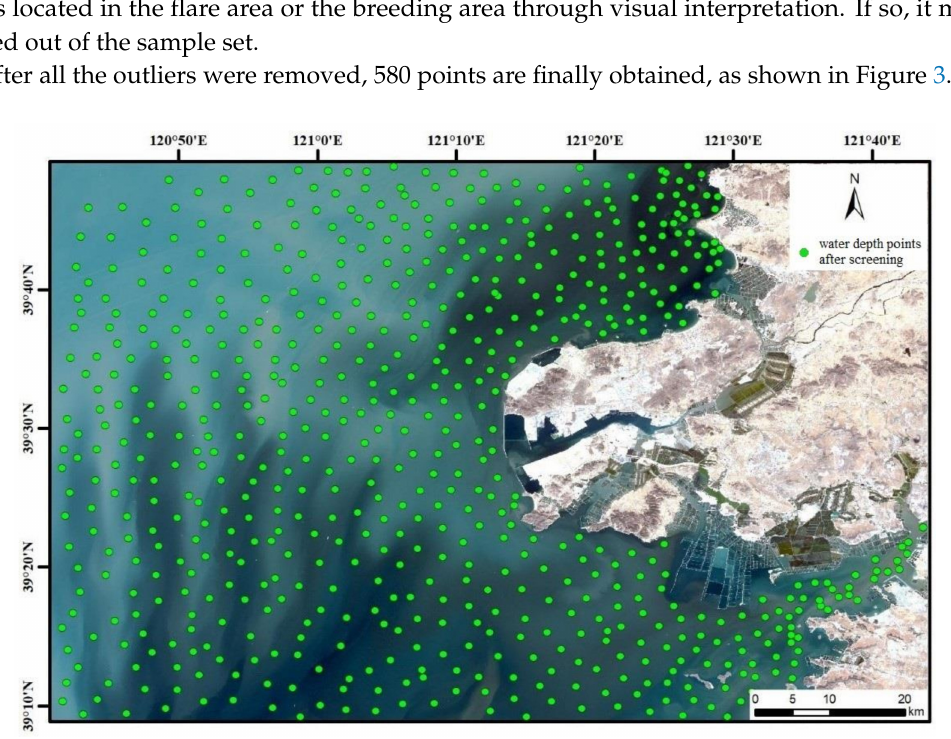
Figure 3. Distribution of water depth points, the green points in sea areas are the obtained samples after